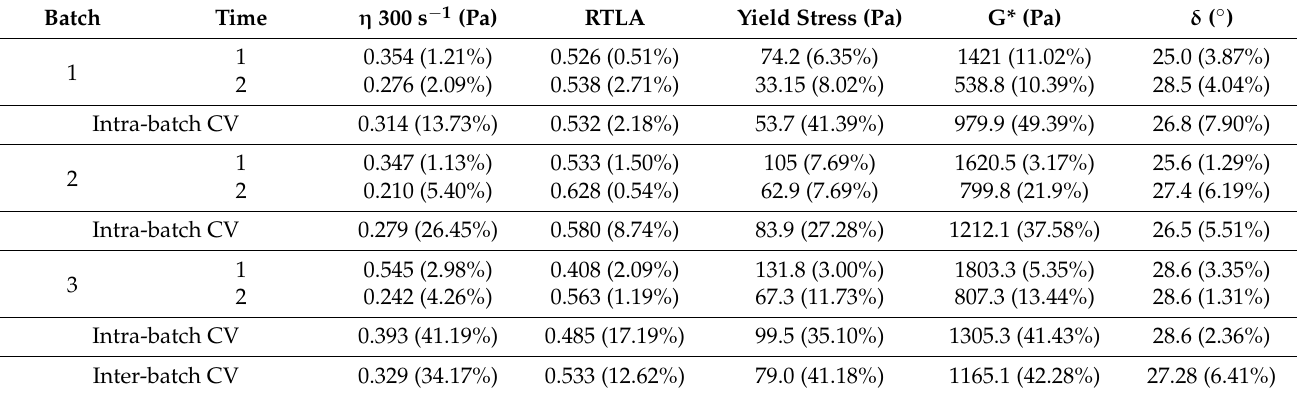
Figure 6. X-ray diffraction patterns of three batches of 0.025% emulsion, pure capsaicin powder, and placebo emulsion. Table 2. Rheological profile of three batches 0.025% w / w capsaicin emulsions. Table shows mean value, and values in brackets show the relative standard deviation (CV%). η : viscosity. RTLA: relative thixotropic loop area, G*: complex modulus. δ : phase angle of delta